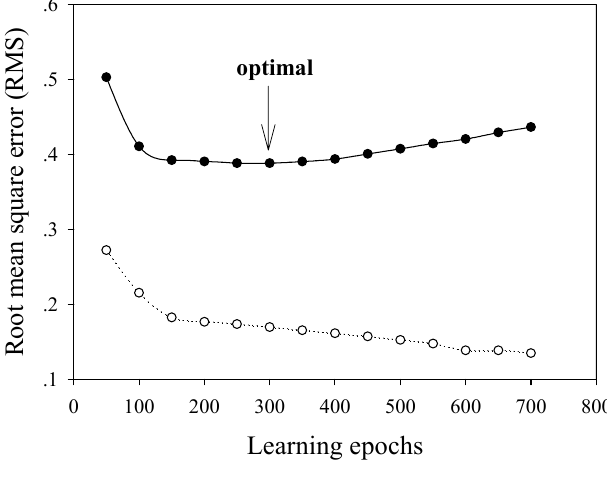
Figure 3. Plot of RMS as a function of the number of learning epochs. The cross-validated test set is represented as a solid line while the training set is represented as a dotted line.